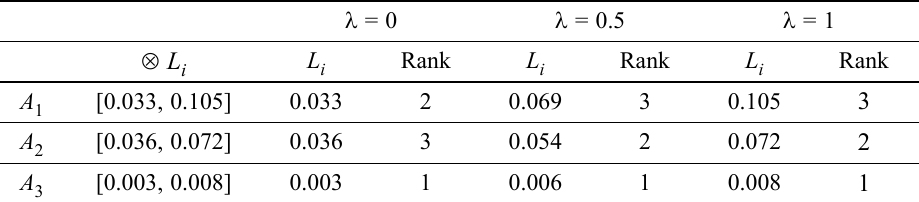
Table 12. Ranking results obtained using proposed approach for p = 2 and characteristic values of coefficient λ λ = 0 λ = 0.5 λ = 1 ⊗ L Rank L Rank L Rank L i i i i [0.033, 0.105] 0.033 2 0.069 3 0.105 0.036 [0.003, 0.008] 0.003 1 0.006 0.008